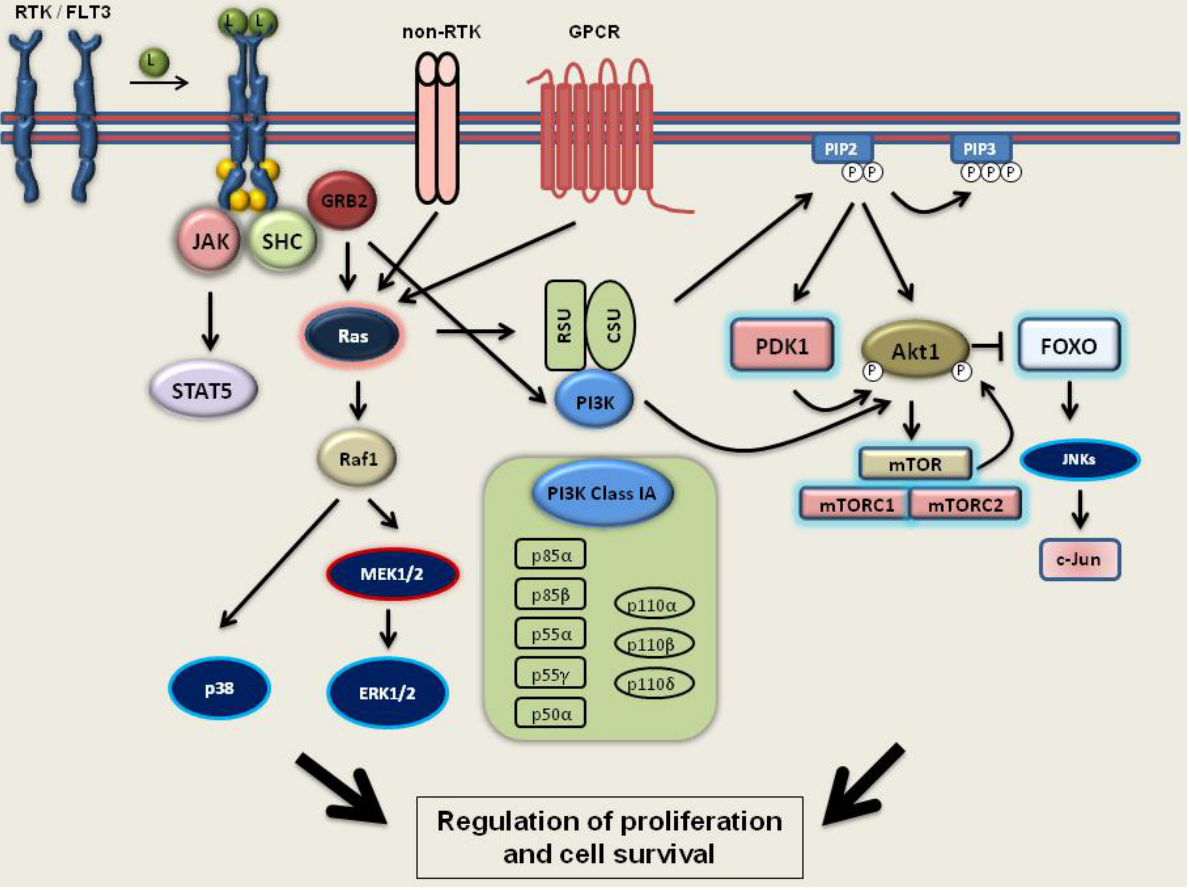
Figure 2. FLT3/PI3 kinase/Akt1/mTOR signaling